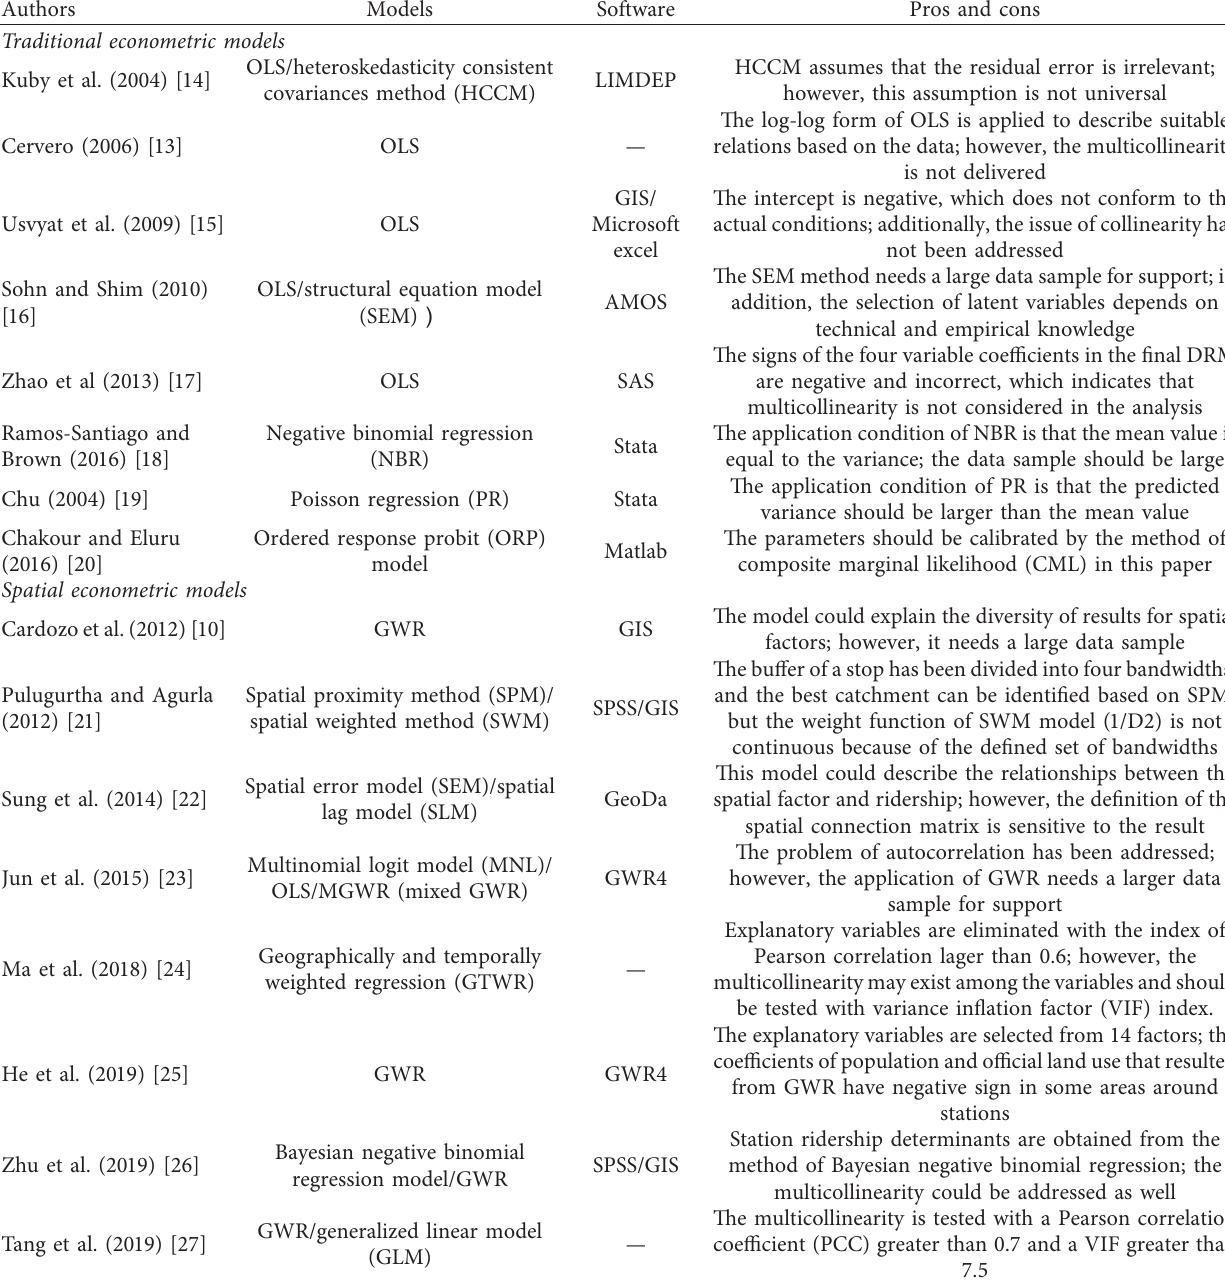
Table 1: Summary of literature on